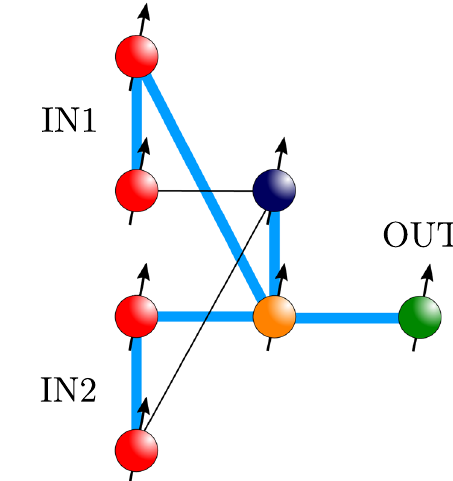
Fig. 4 Reduced Bell-state comparison network. Schematic depic- tion of a network for comparing pairs of Bell states employing fewer qubits to do so than the one presented in the main text. The left- most layer marked in red constitute the inputs to the network, with subsequent layers extracting and comparing information about either the phase (blue) or the excitation parity (orange) of the input states, with the result of the comparison stored in the green output